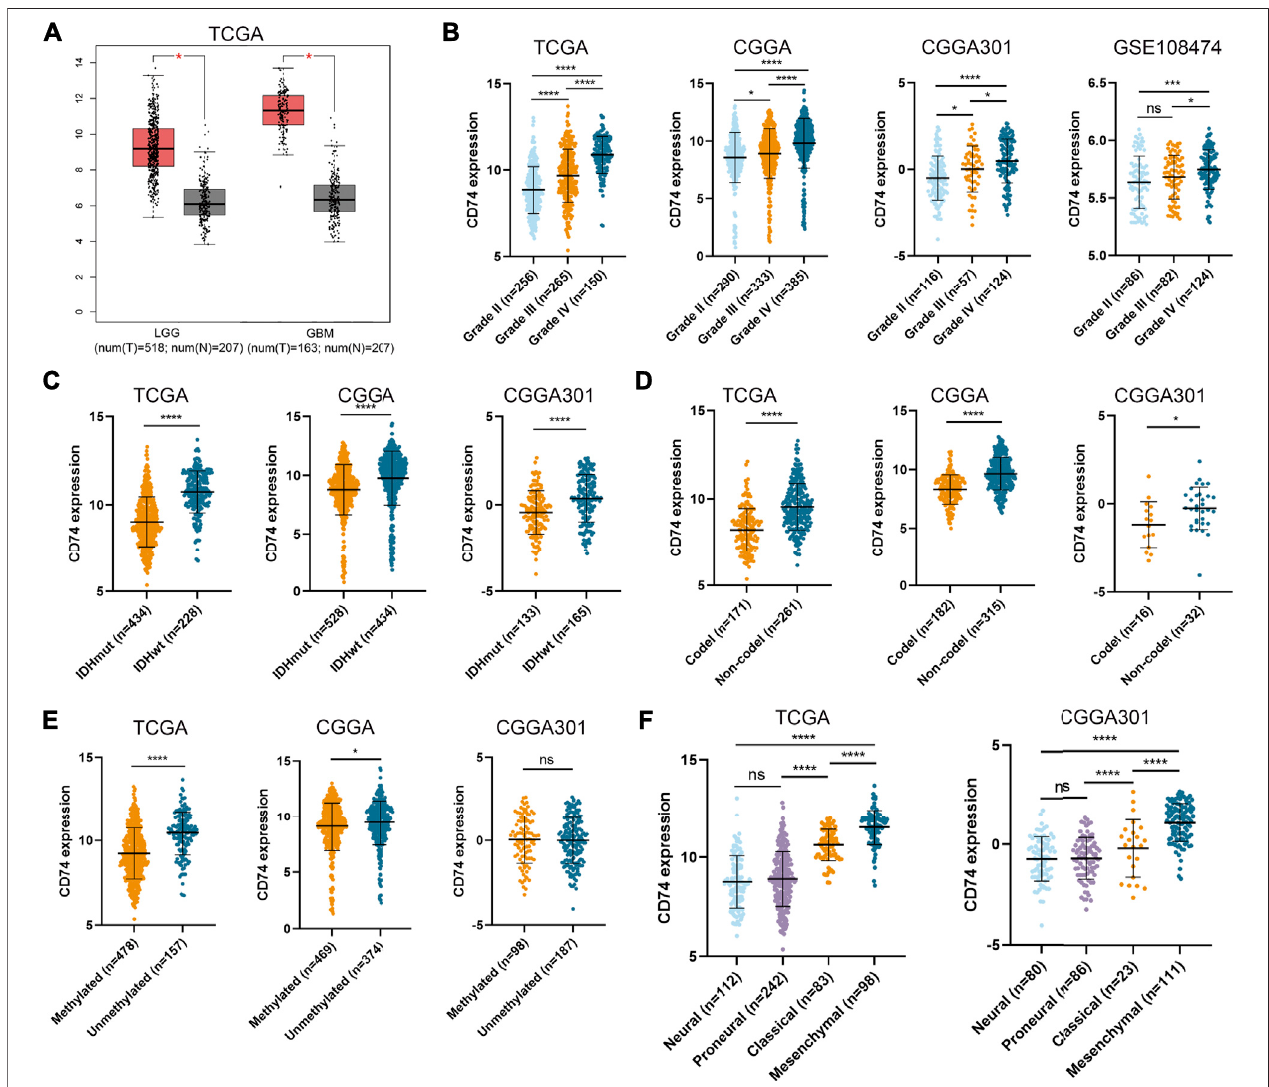
FIGURE 1 | Expression of CD74 was associated with glioma malignancies. (A) Expression of CD74 in glioma and normal brain tissues. The red and grey box representedtumor and normaltissues,respectively. B-E.CD74expression indifferentgrades (B) ,IDHstatus (C) ,1p19q status (D) ,and MGMTstatus (E) ofgliomas. F. Expression of CD74 in different molecular subtypes of glioma. G Immunohistochemistry staining of CD74 in glioma and normal brain tissues. Data were represented as mean ± standarddeviation bydot plot. IDH:isocitratedehydrogenase;MGMT: O6-methylguanine-DNA methyltransferase.*, p < 0.05; ***, p < 0.001;****, p < 0.0001; ns, no signi fi